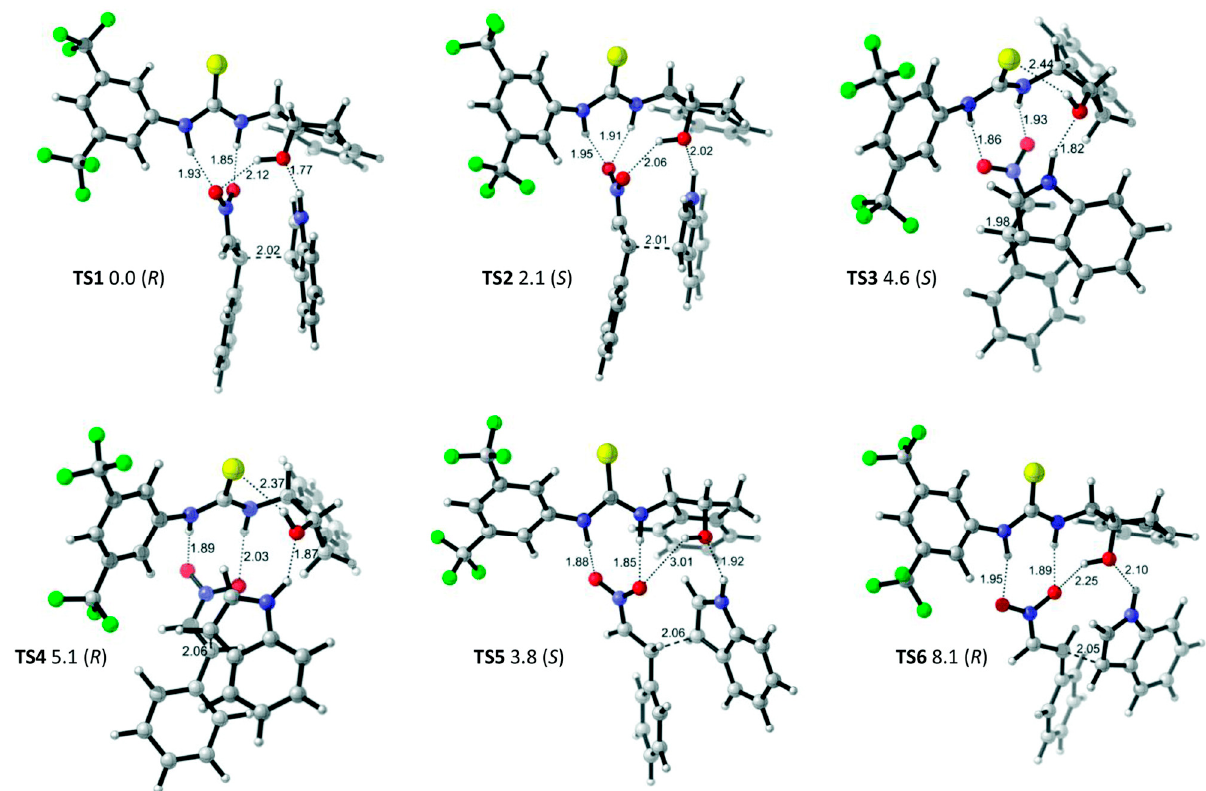
Figure 16. Transition states for the Friedel–Crafts alkylation with catalyst (1 R ,2 S )- C11a . The relative free energies are given in kcal mol − 1 and the distances in Å. Reprinted and adapted from Organic and Biomolecular Chemistry with permission from the Royal Society of Chemistry [39].